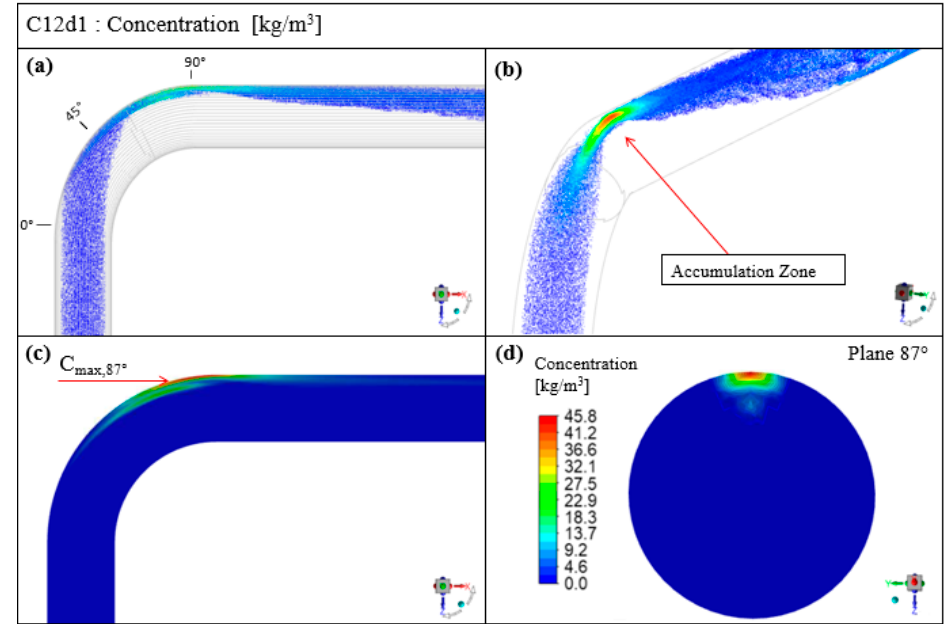
Figure A2. Results of particle concentration. Reference Case C12d1. ( a ) Instant positioning of the X-Z plane particles ( b ) Instant positioning of the particles in 3D view ( c ) Concentration contour in the X-Z plane of the mid-section of the pipe ( d ) Concentration contour in the Z-Y plane of the maximum concentration cross section. Snapshots are taken for a statistically steady flow.